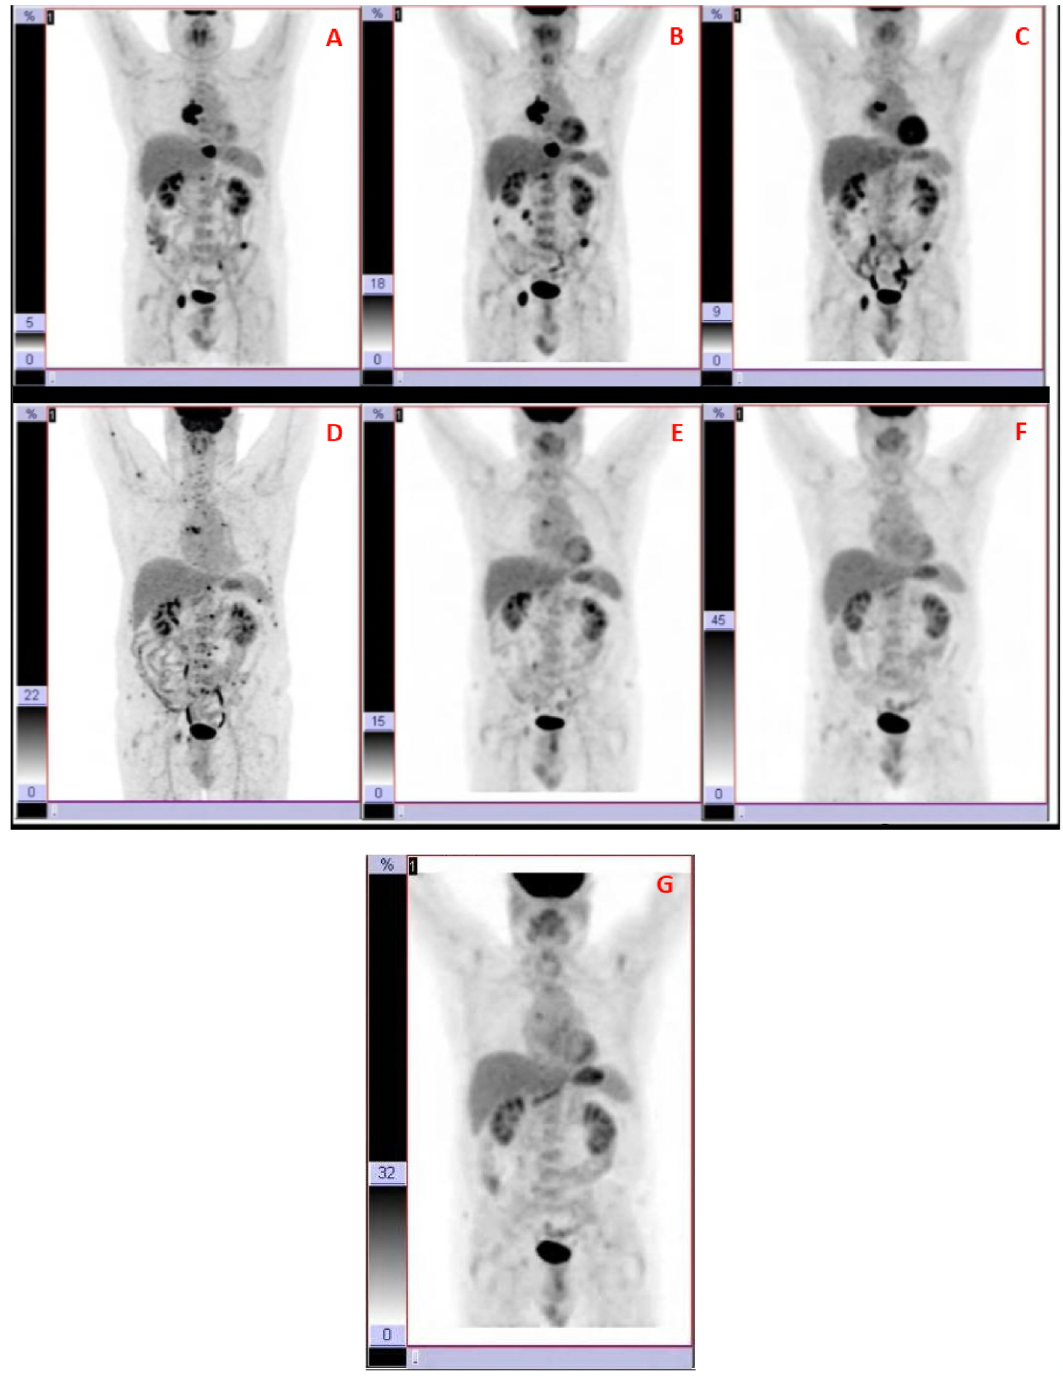
Figure 1. MRI and 18F-DG-PET scan. ( A ) In October 2014, several metastasis at D6–D7, right acetabulum (3cm); vertebral hemi-body D10 (3cm); vertebral body of D12 (2cm); and left iliac crest (1cm) were observed. ( B ) 4 months later, a PET-TAC showed a metabolic stabilization of the disease, but with a slight growth of lesions according to MRI. ( C ) During the following 11 months, the patient remained stable without disease progression. ( D ) In May 2016, a 18 FDG-PET-TAC revealed an important metastatic dissemination all over the skeleton, showing more than 40 small new lesions (<2 cm), and with scarce or null Octreoscan and 123 I-MIBG uptake. ( E ) In December 2016, most of lesions had disappeared according to PET-TAC. ( F ) In July 2017, a new PET supported the previous results, showing the remaining two lesions but with maximum SUV lower. ( G ) In October 2017, 4 months since the last dose of temozolomide, and propranolol as the only treatment (240mg/day), the disease remains controlled according to this last